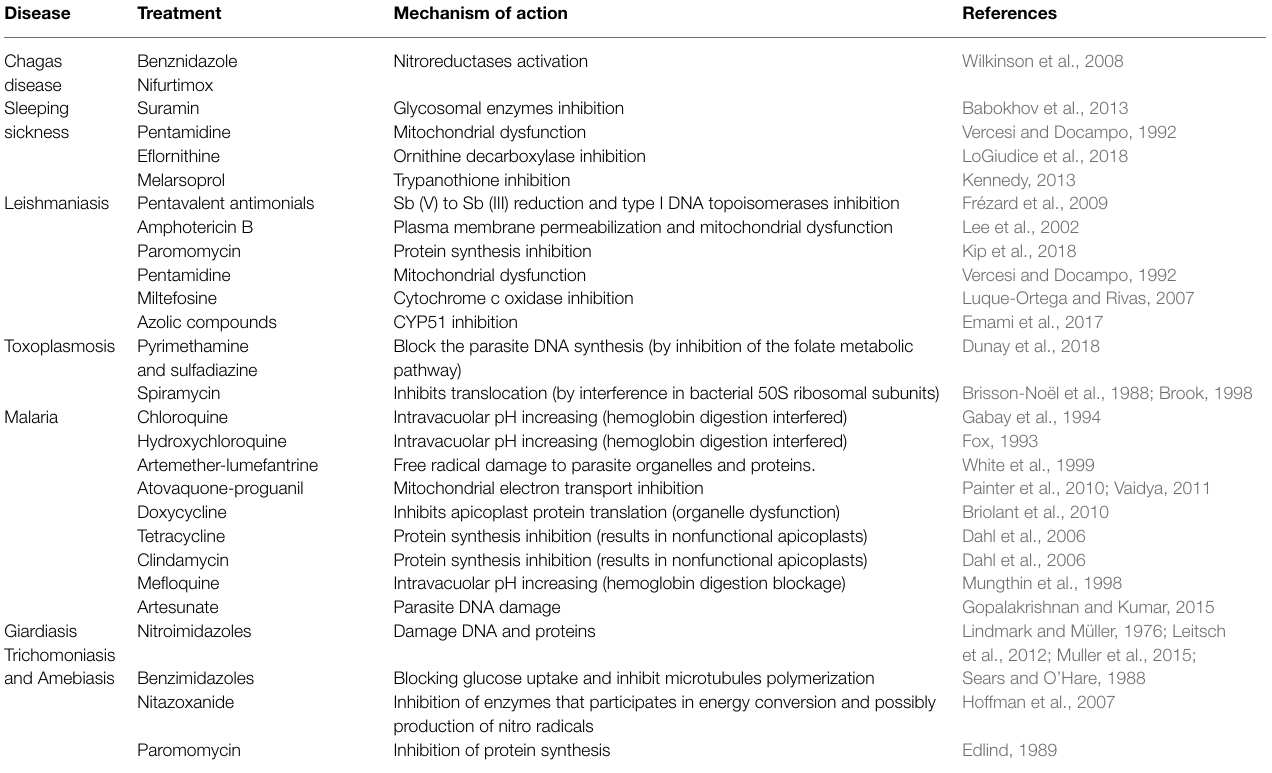
TABLE 1 | The main protozoal infections and their current